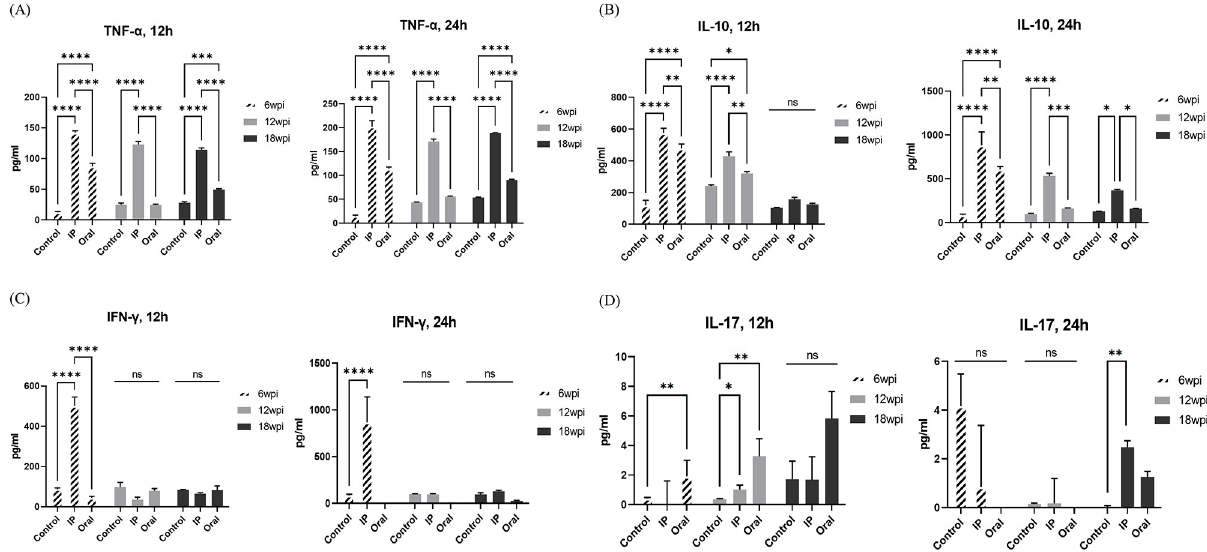
Fig 2. Immunological changes in the murine model after infection with MAP. Amounts of each cytokine in culture supernatant of splenocytes after stimulation with MAP lysates. (A) TNF- α . (B) IL-10. (C) IFN- γ . (D) IL-17. Statistical significance was calculated by ANOVA with Tukey’s multiple comparisons test ( p value, � < 0.05; �� < 0.01; ��� < 0.0005; ���� < 0.0001).